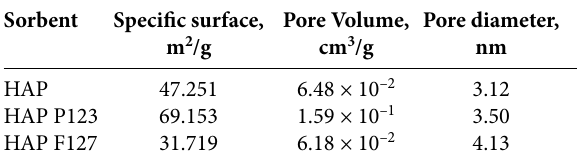
Table 1. Textural properties of the synthesized sorbents.